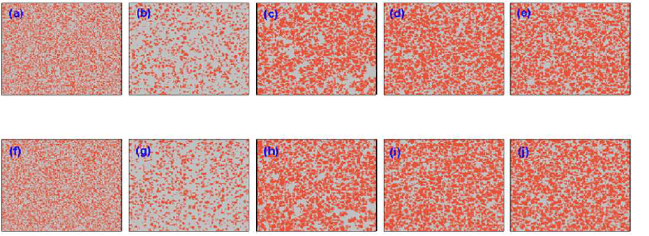
Fig 4. Characteristic snapshots of cooperators and defectors on two independent lattices for a fixed temptation to defect ( b = 1.07) starting from an initial strategy distribution. In the upper row, from panel (a) to (e), snapshots are taken from one lattice at the time step 1, 10, 100, 1000, 50000,respectively; Similarly, in the lower row, we providethe snapshotson the other lattice at the same time step. The orange dots represent the cooperators, and the light gray dots denotethe defectors. The system setup is assumed to be L = 200, MCS = 5 × 10 4 and κ = 0.1 and the tunableparameter α =